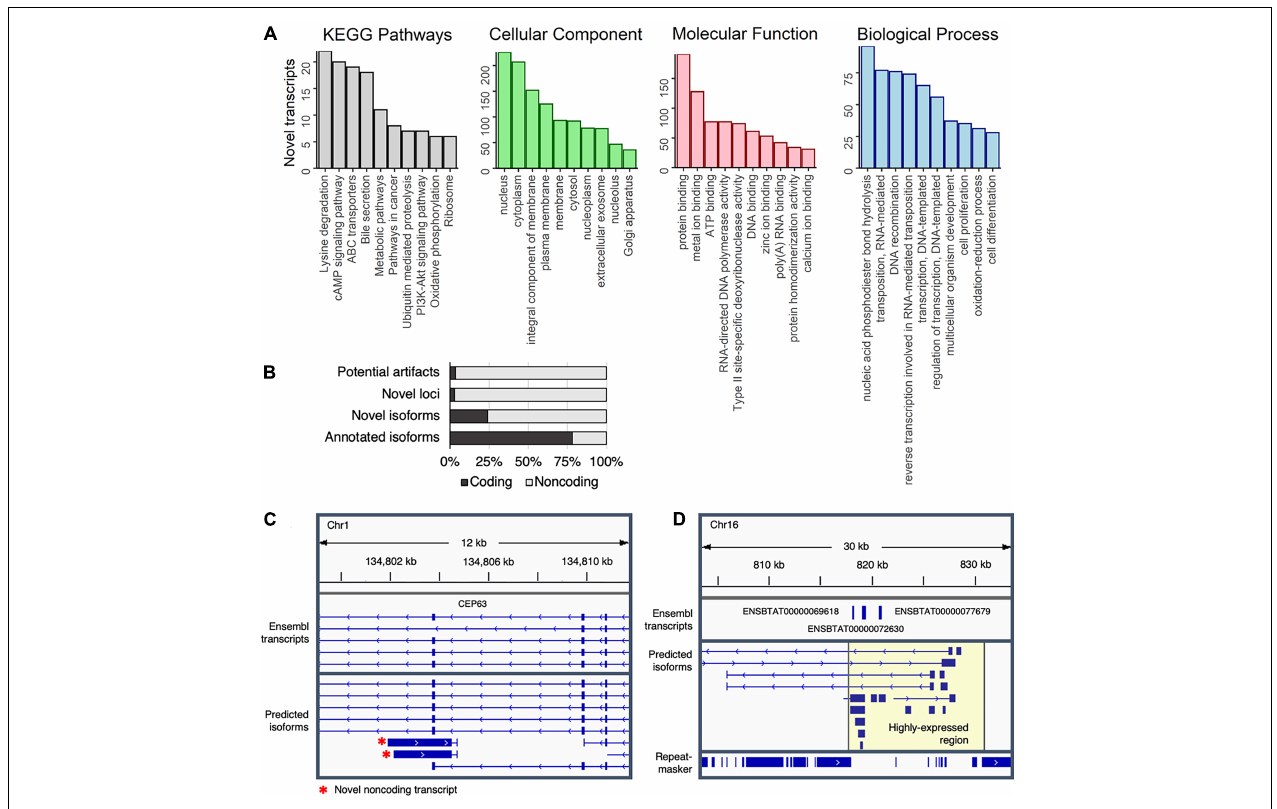
FIGURE 4 | Characterization of predicted transcripts at novel loci. (A) The top ten represented KEGG pathways and GO terms (separated into Cellular Component, Molecular Function, and Biological Process terms) represented in transcripts at novel loci that corresponded to a UniProt identifier. (B) Coding potential of predicted transcripts. (C) Novel non-coding antisense transcript at the CEP63 locus. (D) Highly expressed section of chromosome 16. RepeatMasker track shows repetitive elements, which were depleted in the highly expressed region (highlighted in yellow).